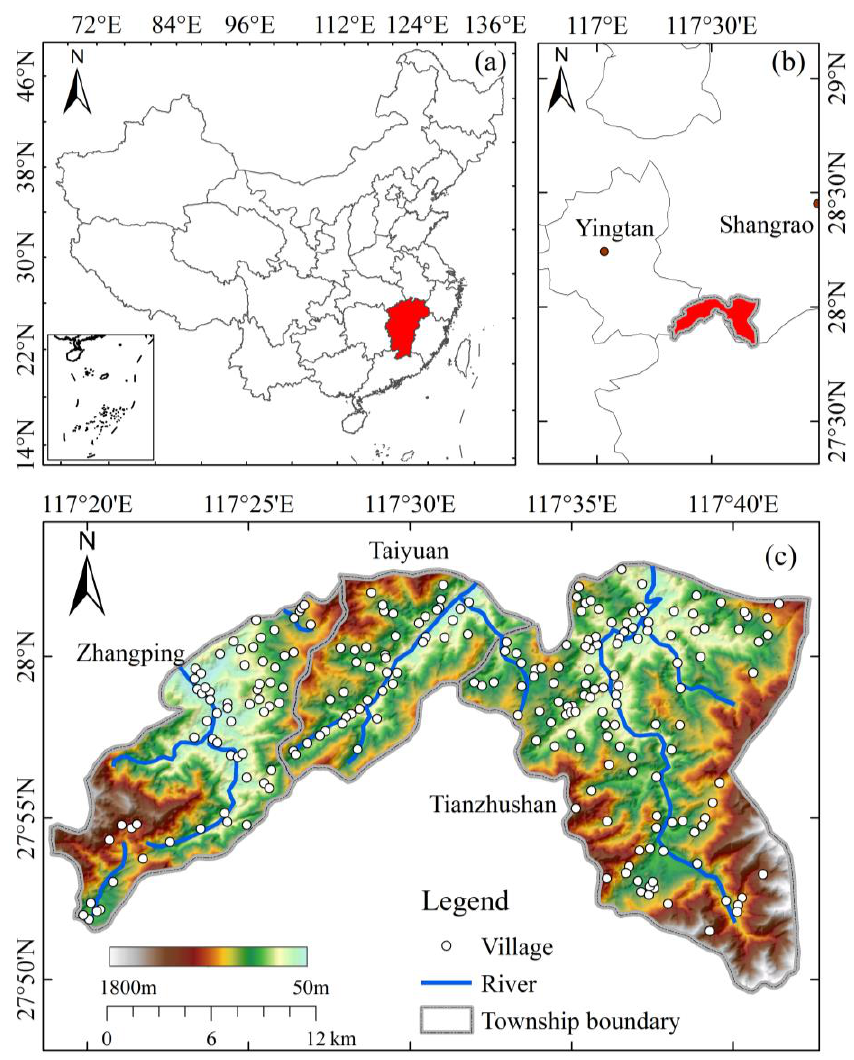
Figure 1. Topographical map of the study area. ( a ) Location of Jiangxi Province in China; ( b ) The location of the research area in Jiangxi Province; ( c ) Spatial distribution of village.